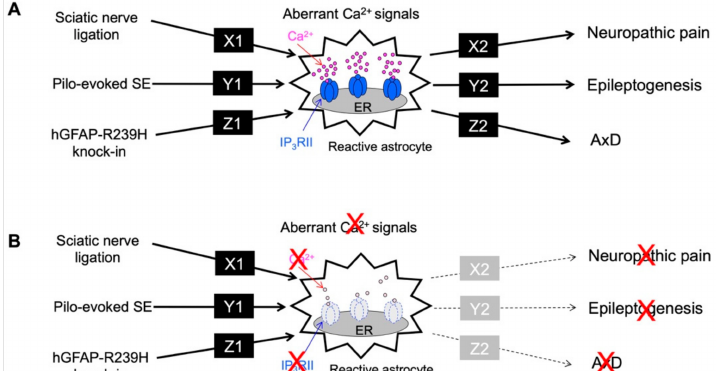
Figure 4. Summary of aberrant Ca 2+ signals and neurodegenerative disorders. ( A ). Sciatic nerve ligation (neuropathic pain model), Pilo-evoked SE (epileptogenesis model), and hGFAP-R239H knock-in (AxD model) caused a common phenomenon of aberrant Ca 2+ signals in reactive